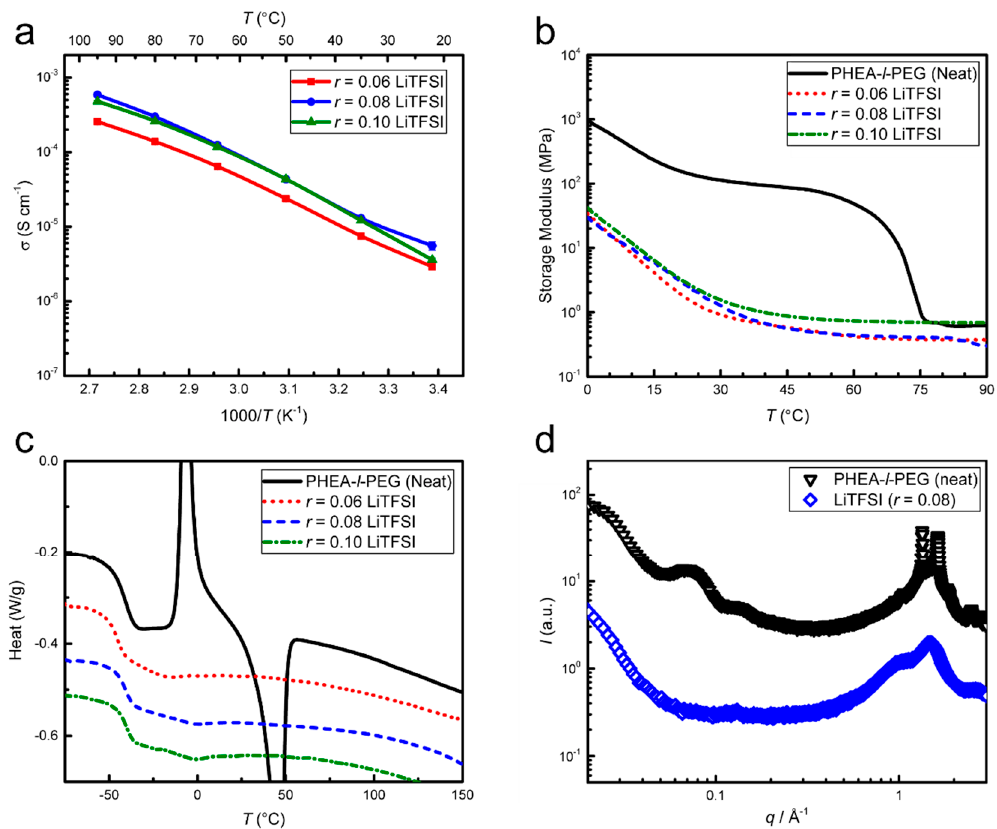
Figure 1. Characterization of SPE-1 as a function of LiTFSI salt concentration. ( a ) The conductivity measured by electrochemical impedance spectroscopy (EIS) shows increases with r and temperature, but plateaus at r = 0.08. ( b ) Dynamic mechanical analysis (DMA) shows a decrease in storage modulus (softening) upon salt addition. ( c ) Differential scanning calorimetry (DSC) (2nd heating at 10 °C min − 1 ) shows that salt addition eliminates sample crystallinity, leaving T g ≈ − 40 °C unaffected. ( d ) X-ray scattering profiles exhibit sharp reflections at scattering vectors q = 1.2 Å − 1 –1.5 Å − 1 in the neat sample, which are reduced to a broad signal for r = 0.08, indicating that salt addition eliminates crystallinity. The broad peaks in the 0.02 Å − 1 –0.2 Å − 1 q -range indicate a disordered morphology on the nm-length scale, which disappears upon salt addition.